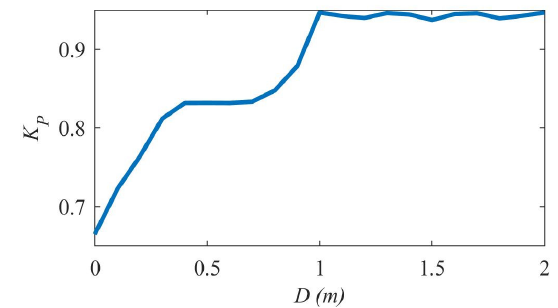
Figure 11. Steady-state value K P course.